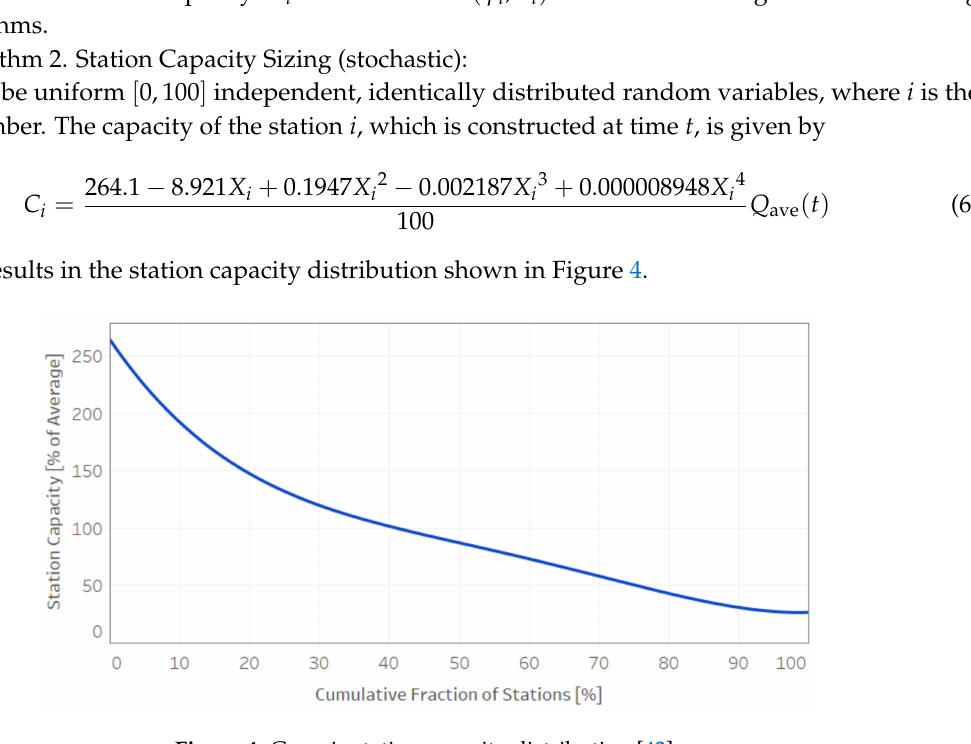
Algorithm 2. Station Capacity Sizing (stochastic):